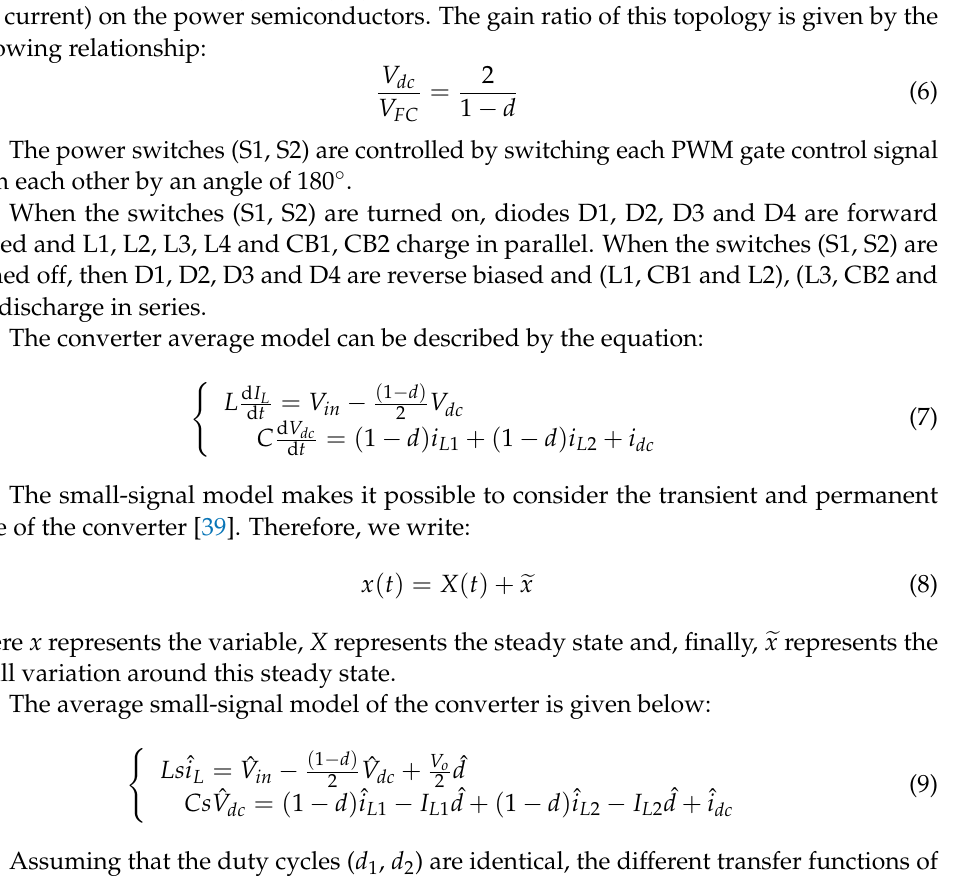
the control signals for the switches S1 and L4) discharge in series.